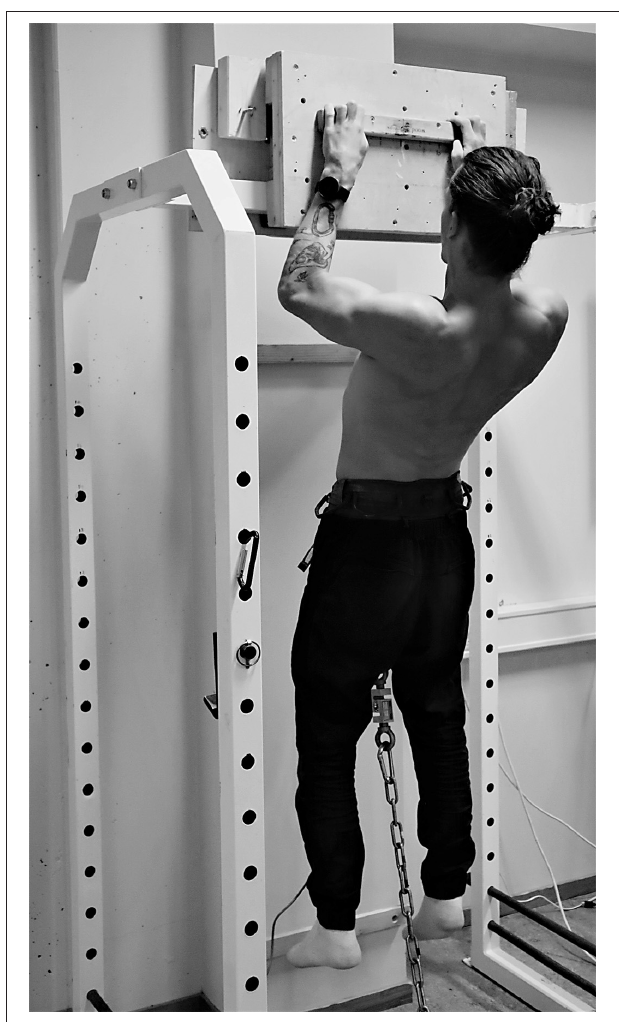
FIGURE 1 | Image showing a participant performing the isometric pull-up test.